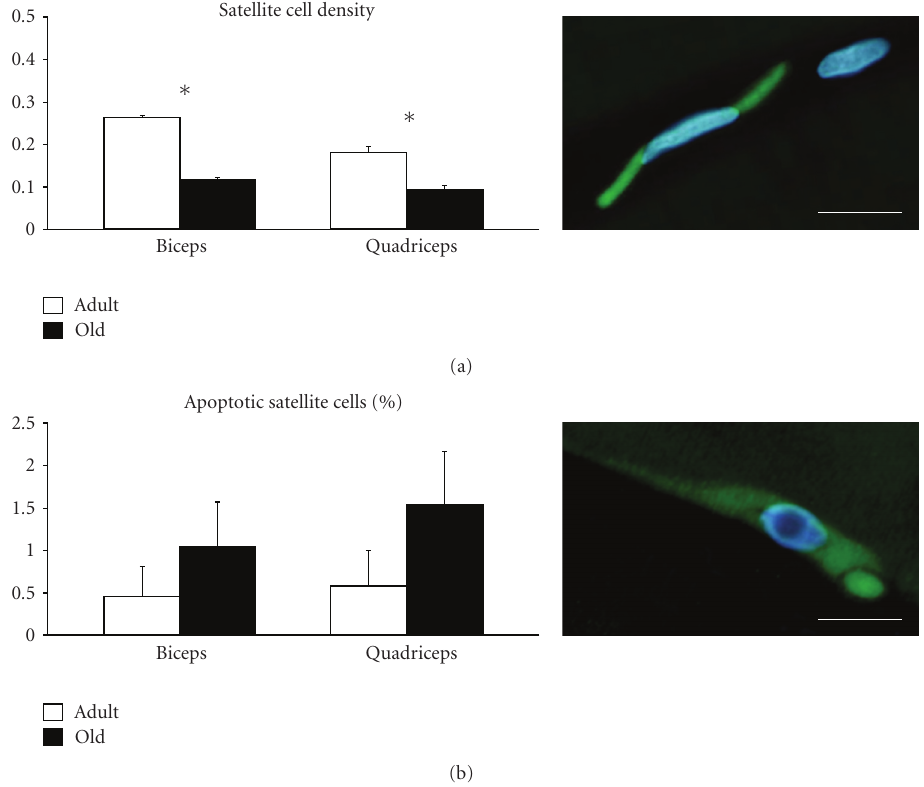
Figure 1: (a) Satellite cell density (number of satellite cells/1000 μm 2 of muscle) in the biceps and quadriceps muscles of adult and old rats (mean ± SE). Asterisks show significantly di ff erent values ( P < 0 . 001 for both muscles). The inset shows a satellite cell labeled with the anti-N-CAM antibody (green fluorescence); DNA was stained with Hoechst 33258. Bar: 10 μ m. (b) Percentage of apoptotic satellite cells in the biceps and quadriceps muscles of adult and old rats (mean ± SE). The values were not significantly di ff erent ( P = 0 . 136 for biceps and P = 0 . 157 for quadriceps). The inset shows an apoptotic satellite cell (green fluorescence); DNA was stained with Hoechst 33258, note the marginated chromatin. Bar: 10 μ